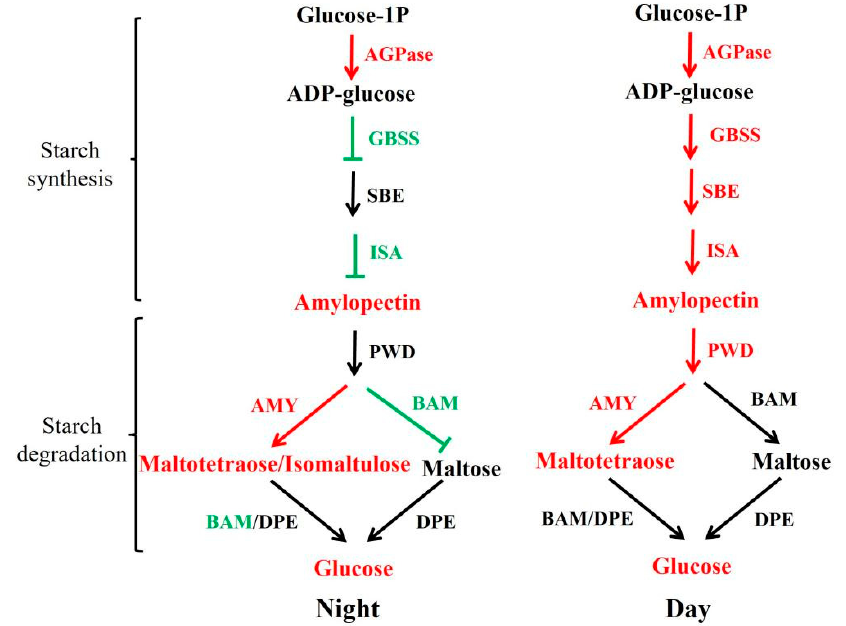
Figure 7. Reconstruction of the starch biosynthetic pathway with differentially expressed genes and metabolites in sub-1 mutant. green represent down-regulated metabolites and genes, red represent up-regulated metabolites and genes. In addition, the red arrow represents boost, the black arrow represents no difference, and T represents inhibition.